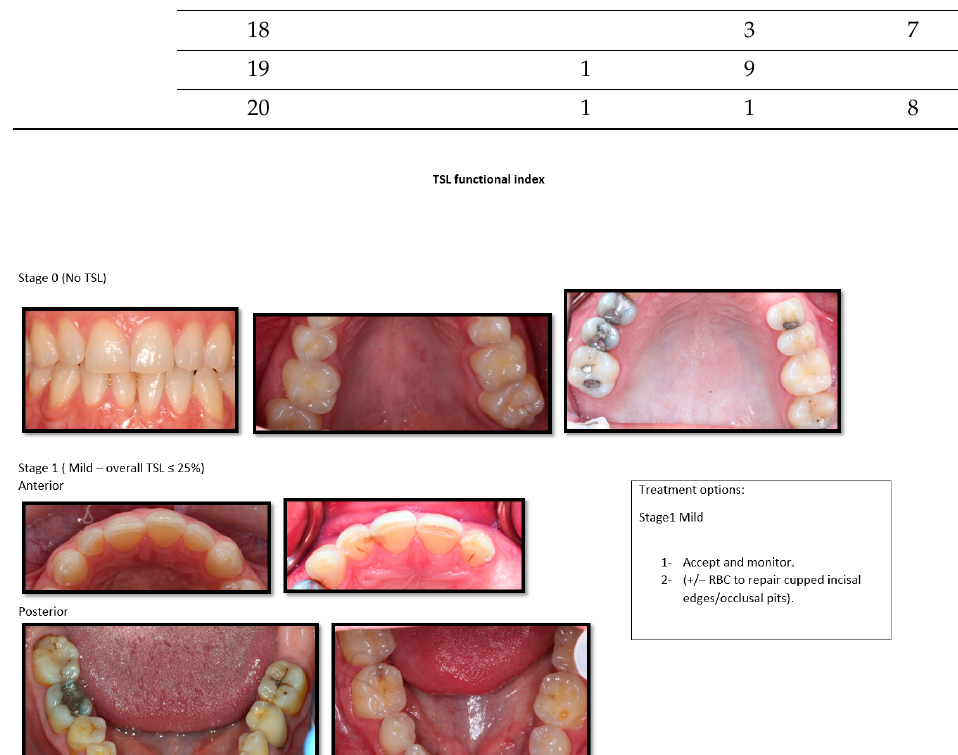
Figure 3. Photographic version of the classification tools with suggested treatment for Stages 0 and 1.